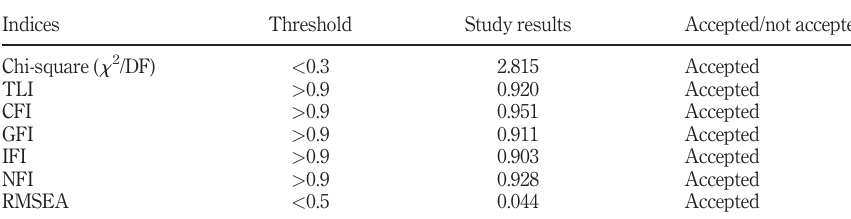
Table 2. Summary of structural and measurement